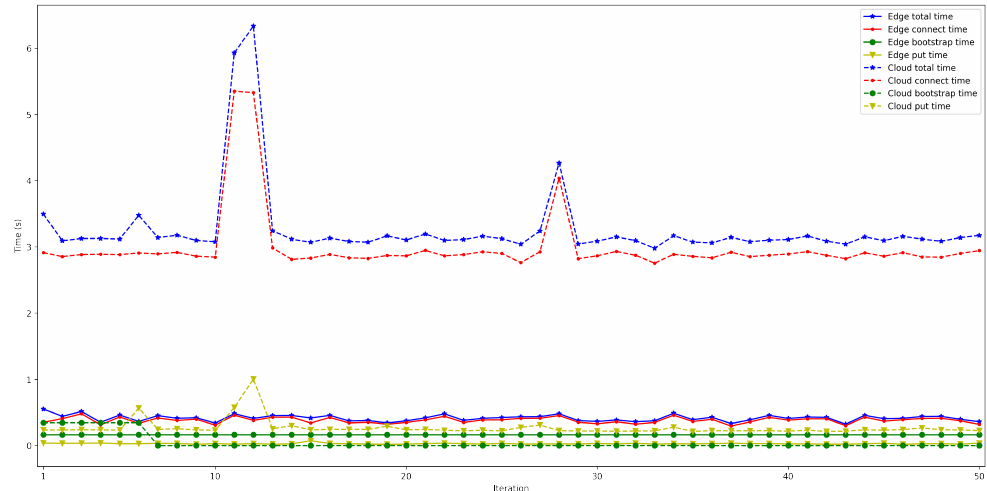
Figure 8. Latency when running the bootstrap node in the edge/Cloud for 50 connected peers.